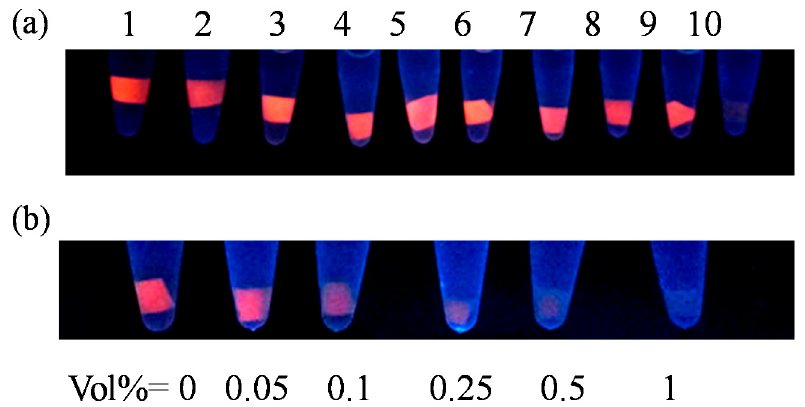
Figure 5. Solvent effects of Cu NCs@ESM generated by VC reduction. ( a ) the solvents are (1) water; (2) acetone; (3) formaldehyde; (4) methanol; (5) ethylene glcycol; (6) isopropanol; (7) n-butyl alcohol; (8) ethyl acetate; (9) cyclohexane; (10) ethanol, respectively; ( b ) The response of prepared Cu NCs@ESM to ethanol solution with different volume fractions, from 0 to 1% under 365 nm UV